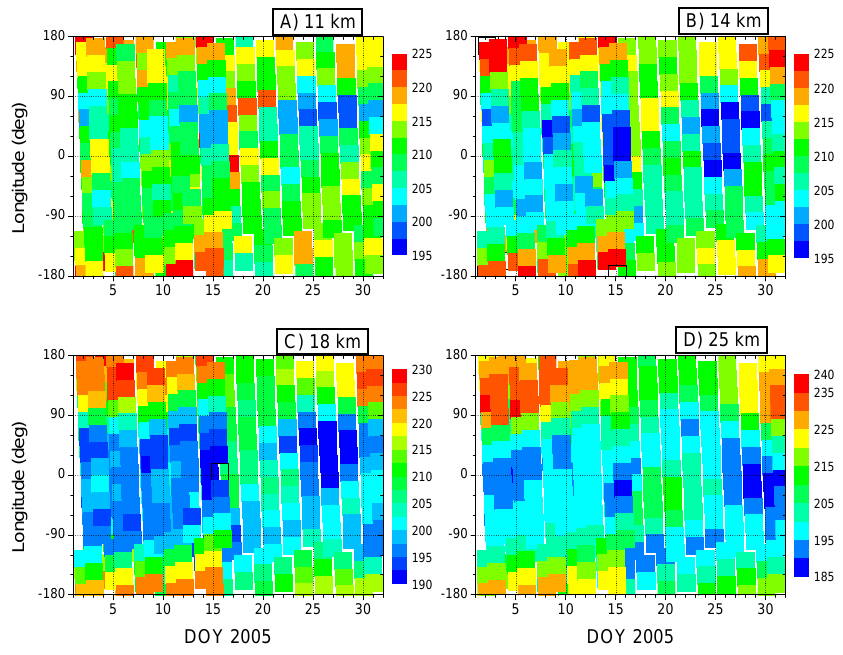
Fig. 6. Temperature distribution in the Northern Polar stratosphere as a function of geographical longitude and time, for four fixed altitudes as indicated on top of each panel. Color scale is shown to the right of each